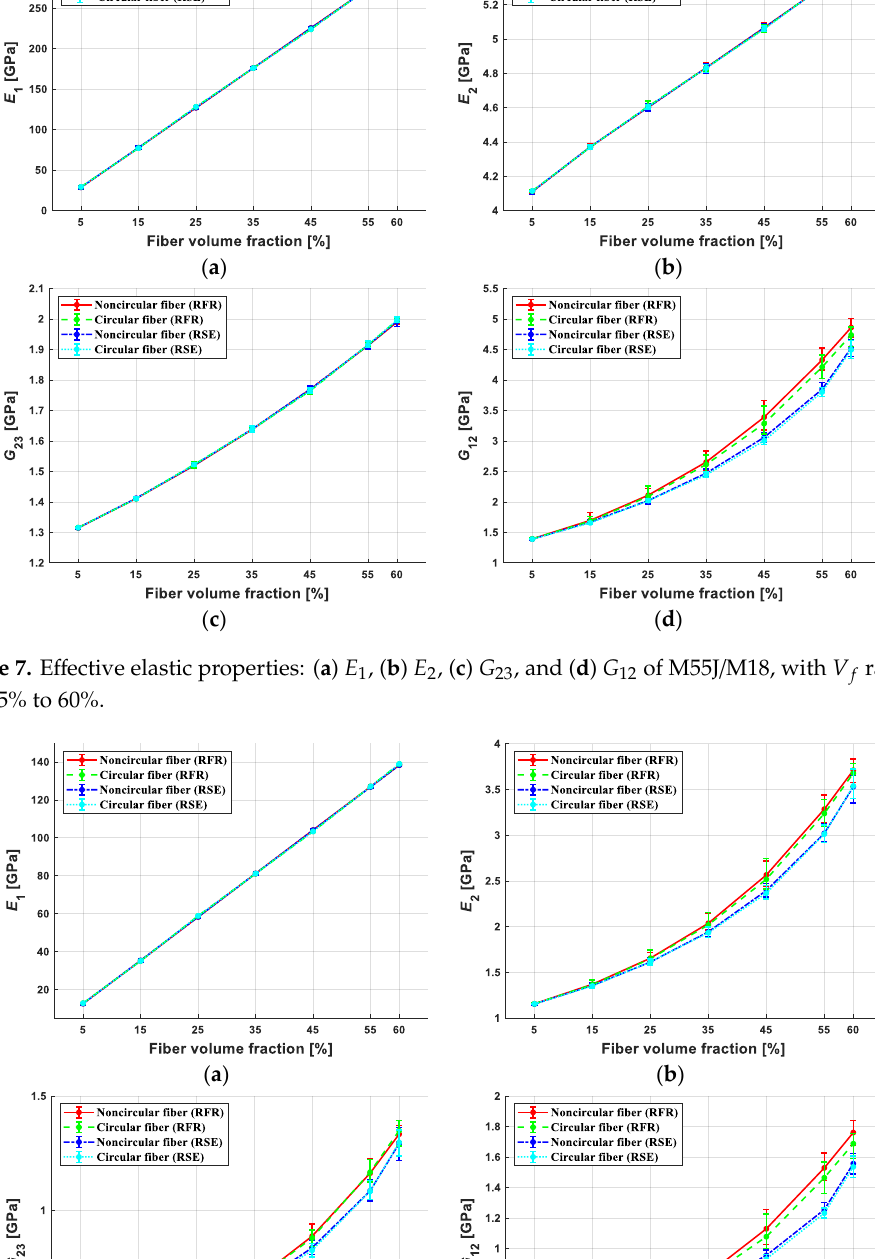
E , ( b ) E , ( c ) G , and ( d ) G of T300/PR319, with f V E , ( b ) G , and ( d ) G of T300/PR319, with f V 1 2 23 12 1 23 12